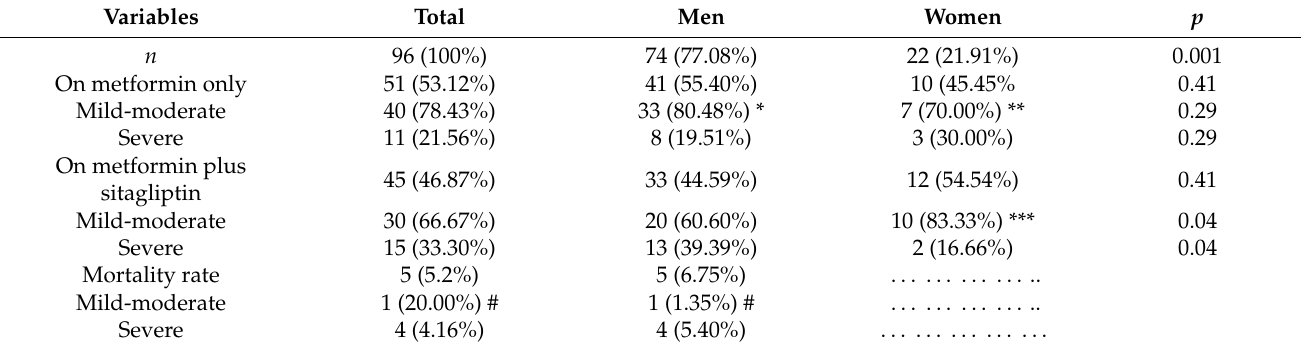
Table 6. Gender difference and COVID-19 severity regarding metformin or metformin plus